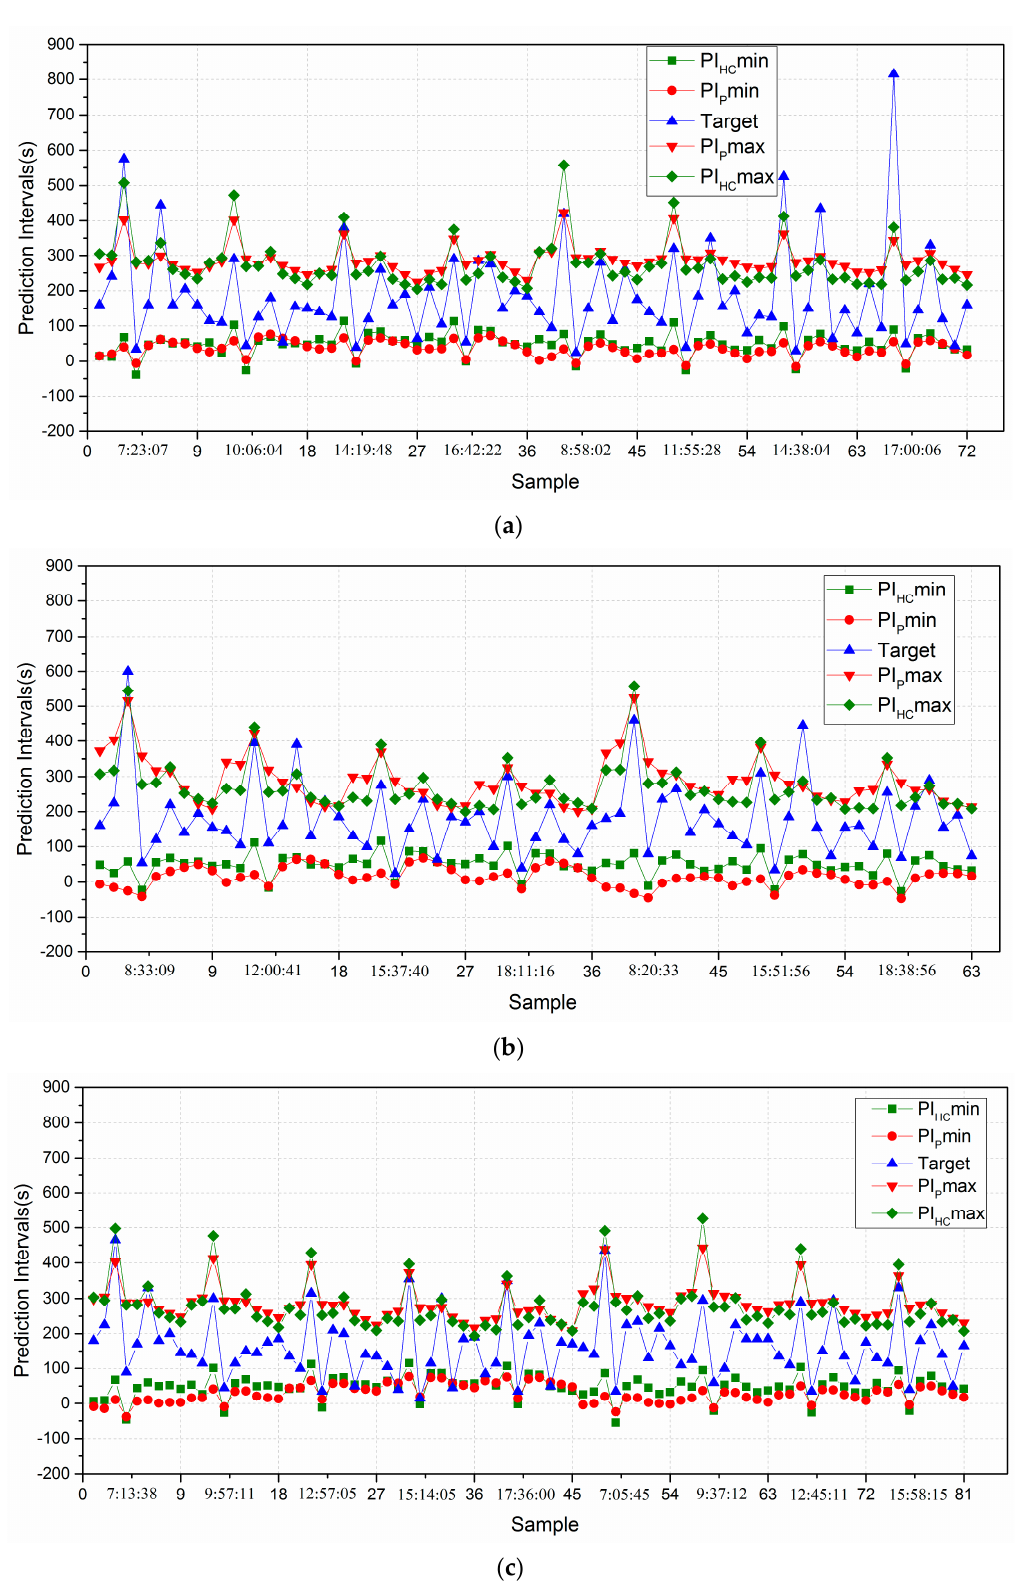
Figure 6. PI results at 80% confidence level: ( a ) PI HC and PI P for 902335; ( b ) PI HC and PI P for 902353; ( c ) PI HC and PI P for 902359.